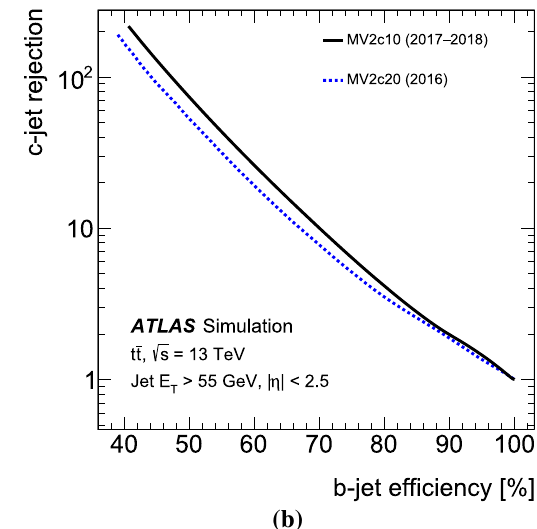
Fig. 10 The expected online performance in terms of a light-flavour jet and b c -jet rejection by the b -jet triggers for the MV2c10 tagger (used during data-taking in 2017 and 2018), and the MV2c20 tagger